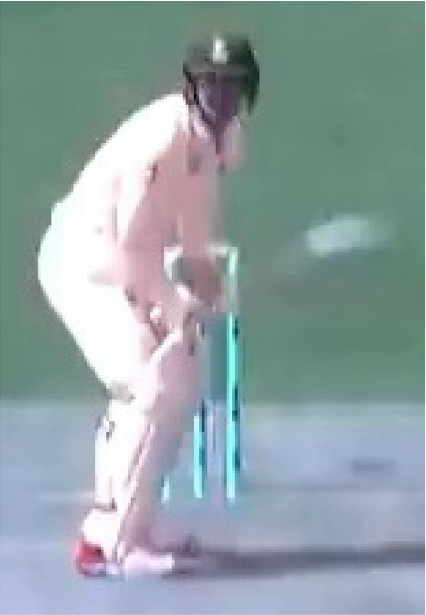
Figure 4. The image that is mispredicted by the Inception V3, Inception Resnet V2, and Xception architectures as a straight backlift, where the image represents a lateral backlift 35